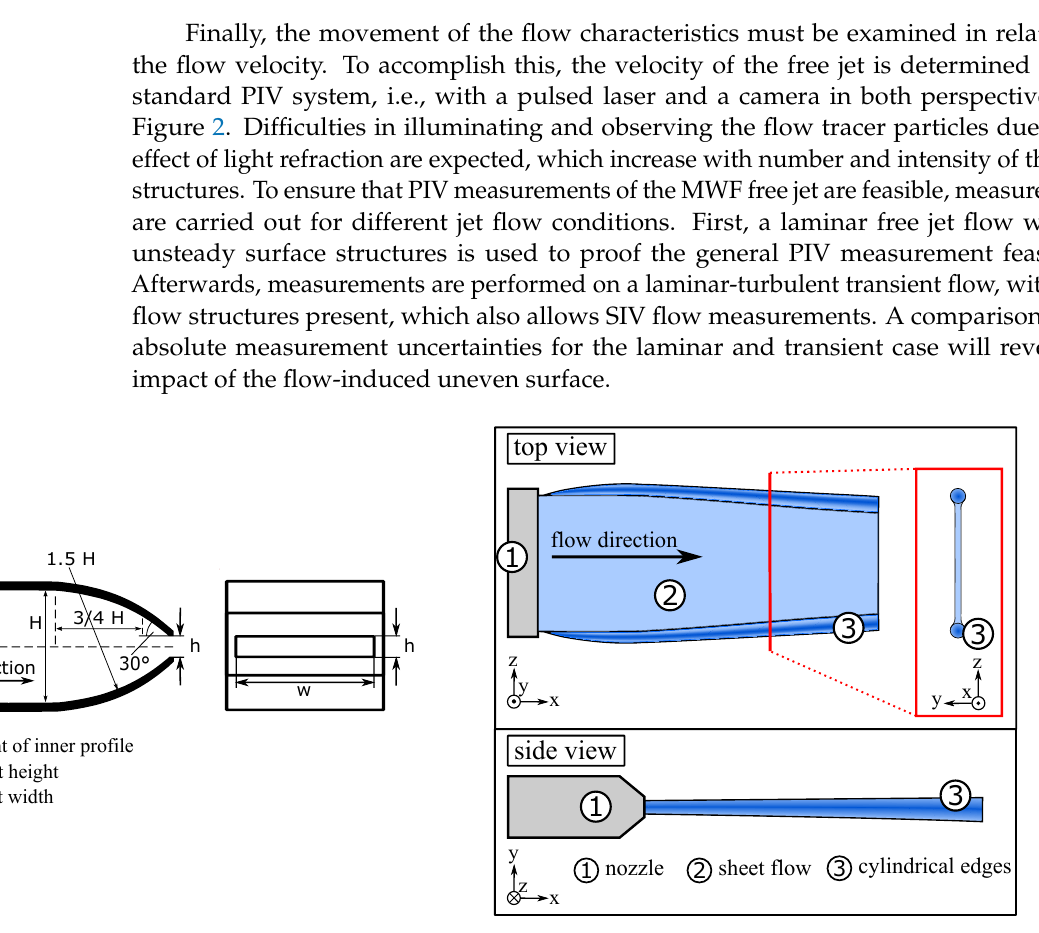
Figure 2. Schematic representation of the flow generation and the velocity measurement in a grinding machine with the laser light sheet illumination for PIV and the diffuse LED backlight illumination for the shadowgram imaging. Recordings are taken with a camera looking in z -direction, centred at the height of the nozzle orifice and moved along the x -axis according to the investigated flow region: ( a ) side view without camera; ( b ) top view.